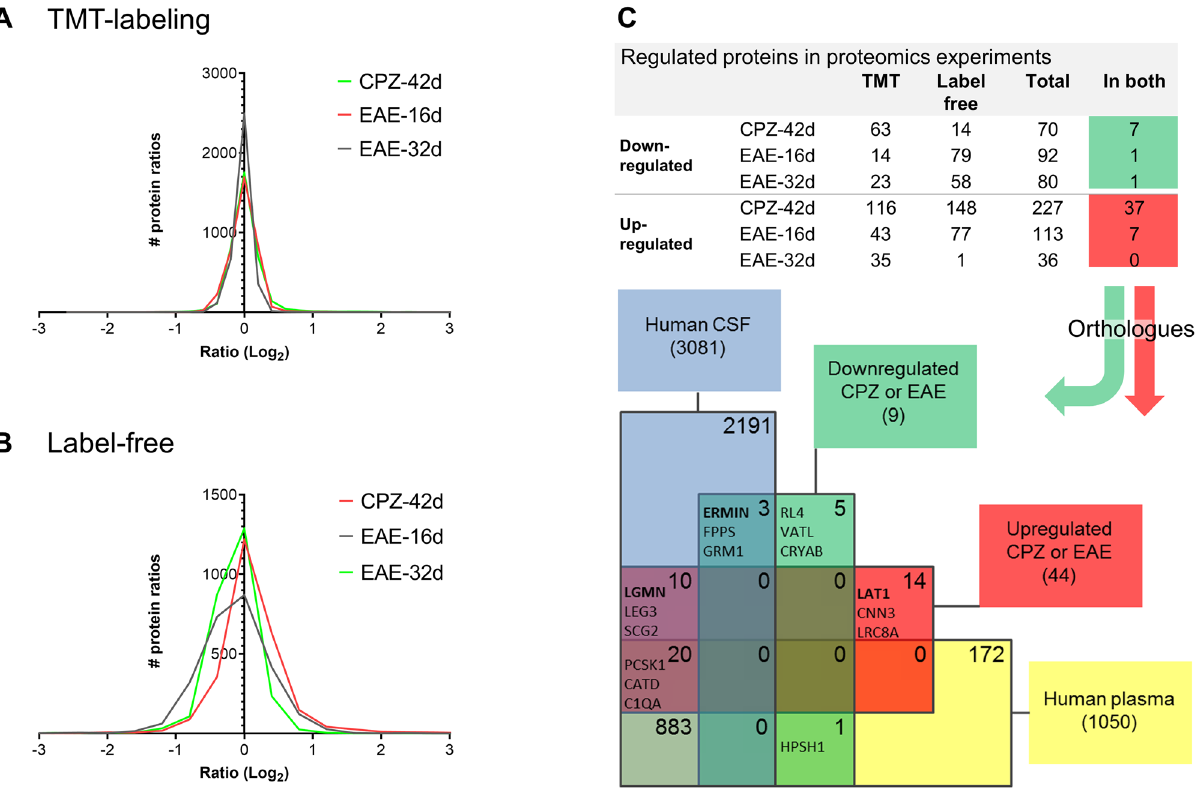
Figure 1. Proteins quantified in EAE and CPZ frontal cortex and human orthologues in CSF and plasma. ( A ) Frequency distribution of all normalized log 2 ratios for proteins quantified using TMT-labeling in frontal cortex in CPZ-42d, EAE-16d and EAE-32d divided by the respective controls. The TMT data was normalized using the log 2 minus the condition median value. The relative numbers of proteins in the ratio bins were automatically determined by GraphPad and presented as continuous lines. ( B ) Frequency distribution of all normalized log 2 ratios for proteins quantified using label-free in frontal cortex in CPZ-42d, EAE-16d and EAE-32d divided by the respective controls. The label-free data was normalized using the default algorithm in Progenesis LC–MS. The relative numbers of proteins in the ratio bins were automatically determined by GraphPad and presented as continuous lines. Slight shifts/shoulders in the frequency distribution plots are due to that the label-free protein quantification is based on the sum of the quantified peptide features with proteins ID’s assigned and the peptides being unique for the protein. The normalization was performed on all peptides. The log2 protein ratios are thus based on a selection of the peptide features from the LC–MS runs. ( C ) Number of significantly regulated proteins in the conditions CPZ-42d, EAE-16d and EAE-32d relative to respective controls using TMT-labelling and label-free proteomics. The numbers of proteins regulated in both methods are shown, downregulated squared in green and upregulated in red. The human orthologues of the proteins regulated in both TMT and label-free were compared to the CSF and plasma proteins in the CSF-PR database 21 . The Venn diagram shows how many protein accession numbers that were shared by the respective proteomes, and some of the most relevant regulated consistency, immunohistochemistry on all sections was performed at the same time. Primary antibodies were: anti-Legumain (LGMN), anti-PLP, anti-HLA-DR. The tissue sections were counterstained with hematoxylin